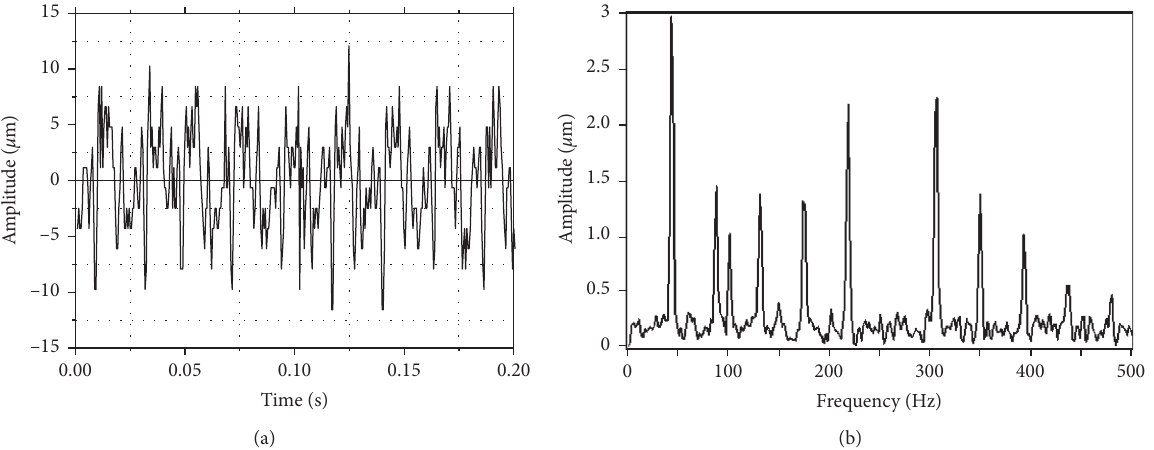
Figure 8: Horizontal vibration test results of spindle front end (2600 r/min). (a) Time domain oscillogram of horizontal vibration. (b) Frequency spectrogram of horizontal vibration.